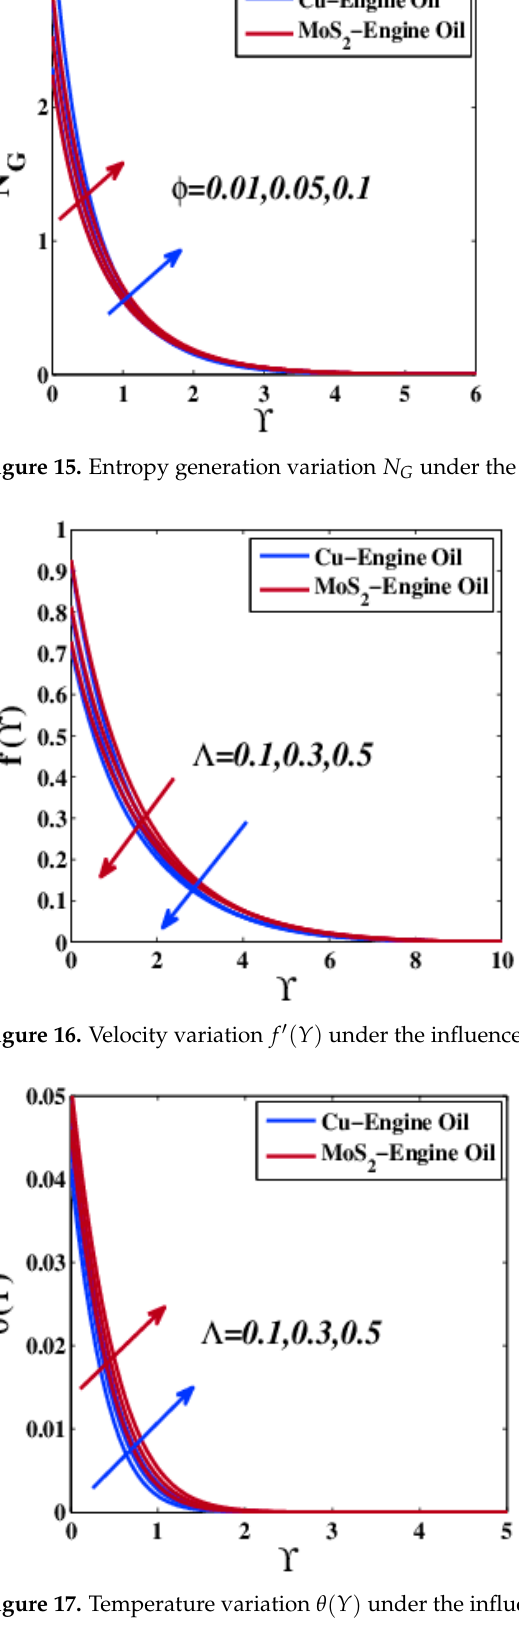
Figure 17. Temperature variation 𝜃(𝛶) under the influence of 𝛬 .